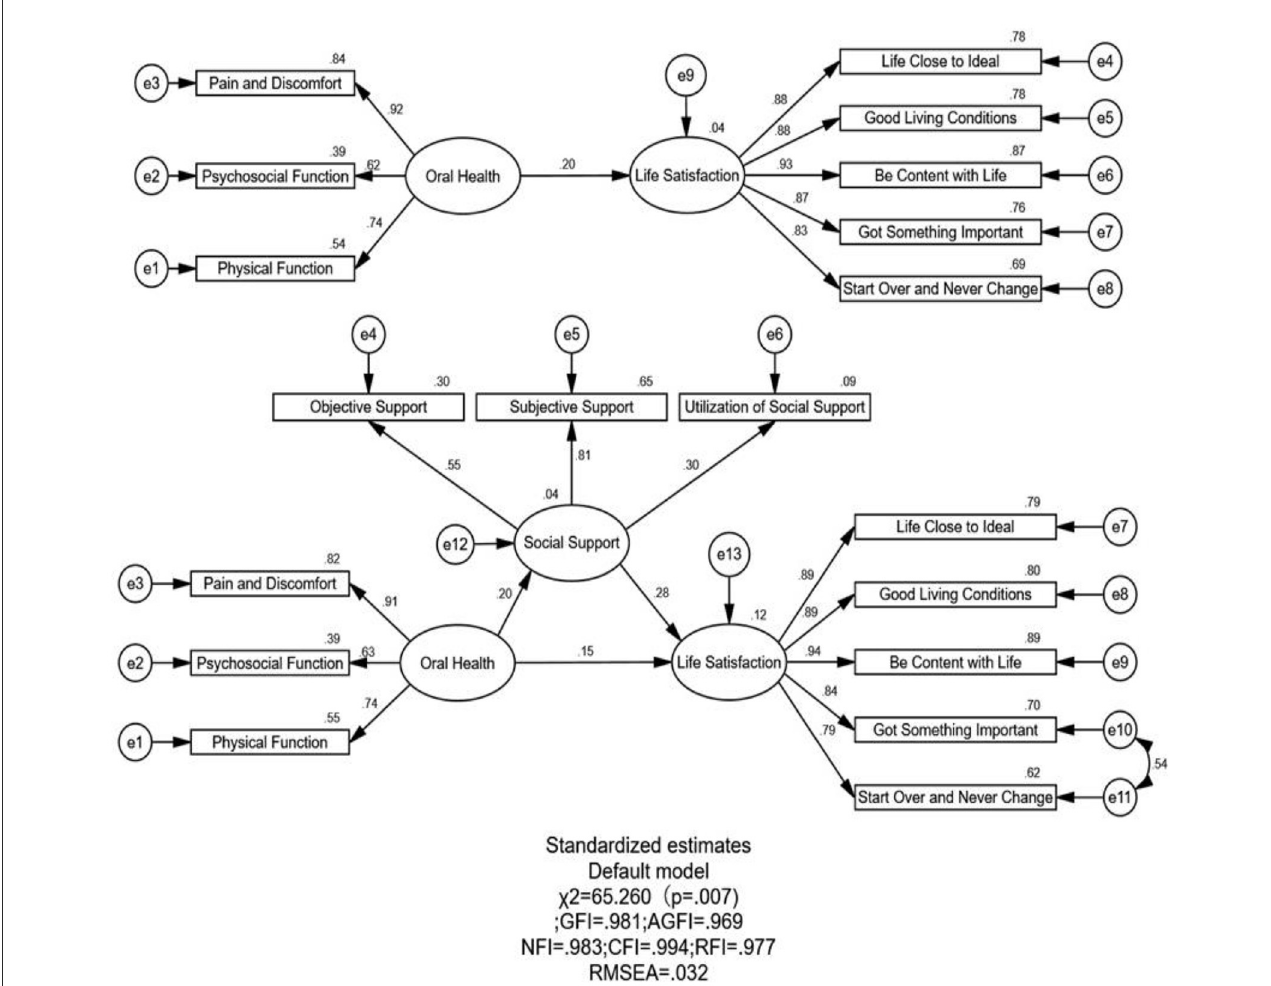
FIGURE2 Path diagram of the association between oral health and life satisfaction of the MEFC in Weifang, China in with social support as a mediator. The coefficient in the parentheses are shown and all paths are statistically significant.